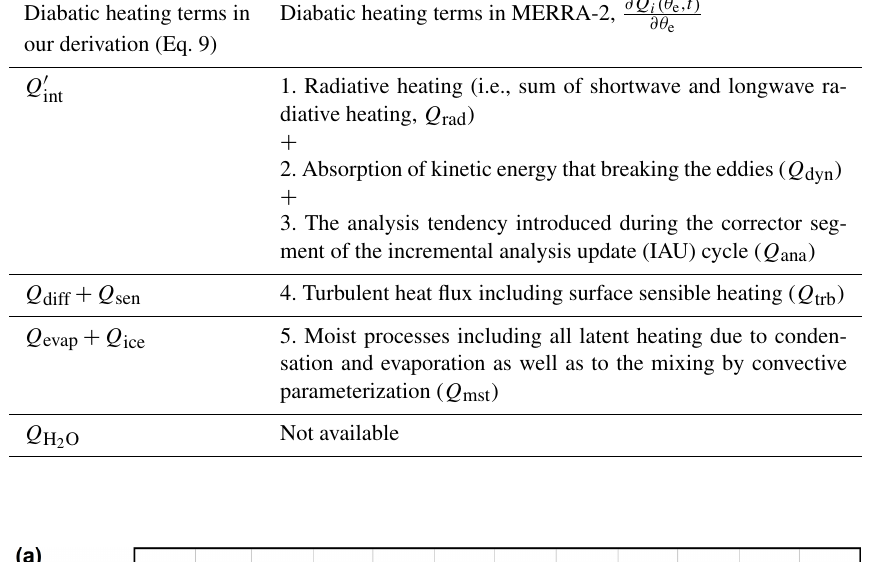
Table 1. Correspondence of heating variables between our derivation (Eq. 9) and MERRA-2. Diabatic heating terms in